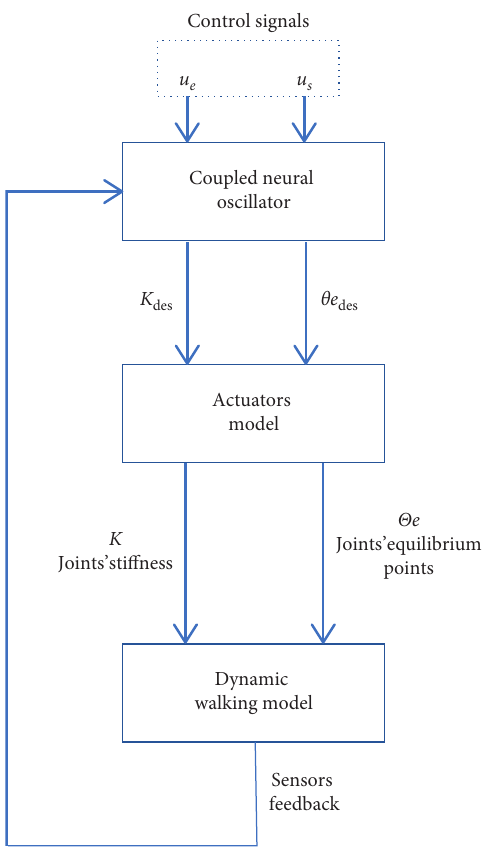
Figure 2: The diagram of the proposed control scheme.